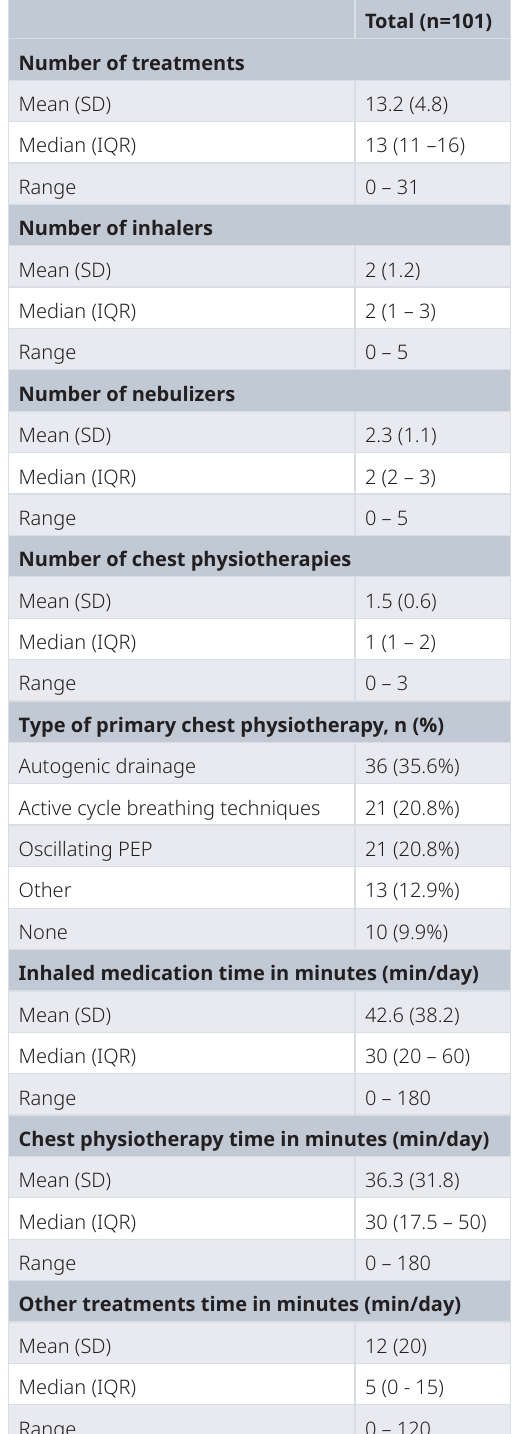
Table 4. Descriptive statistics for the received treatments at the time of the